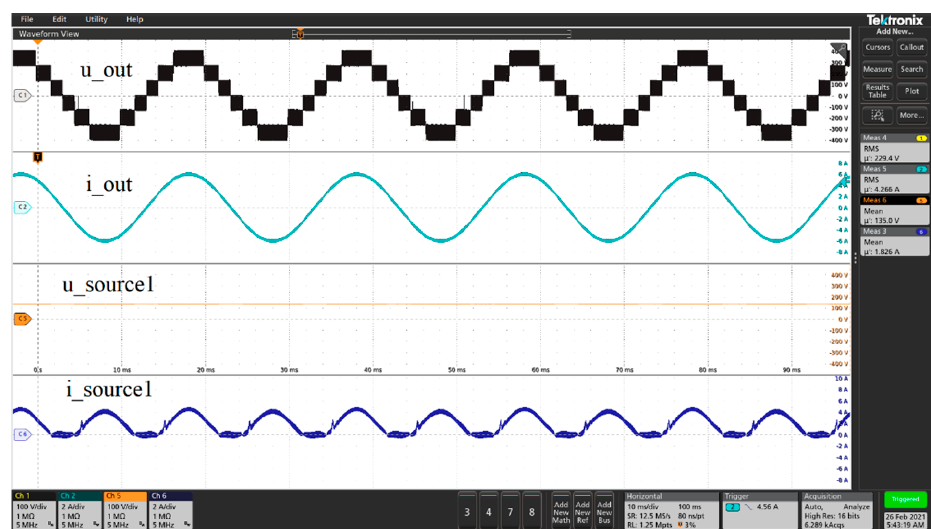
Figure 21. The output voltage ( u out [100 V/div]) and current ( i out [2 A/div]) of the inverter, as well as the voltage ( u source1 [100 V/div]) and current ( i source1 [2 A/div]) of DC power supply, connected to the C 1 DC-link capacitor; 10 ms/div.